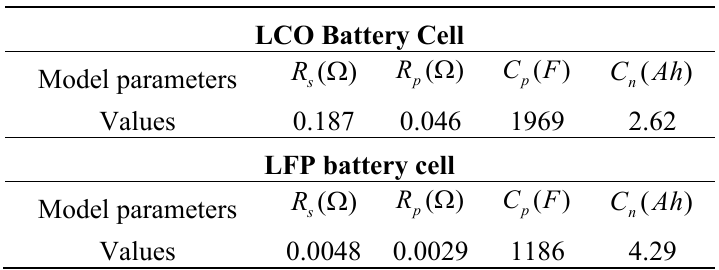
Figure 5. SOC-OCV curves: ( a ) LCO battery cell; ( b ) LFP battery cell. Table 3. Model